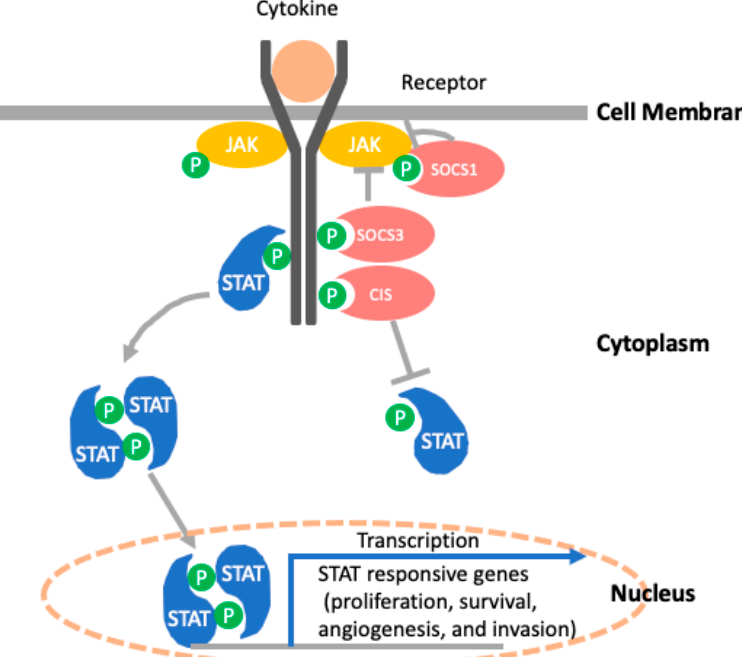
Figure 2. The representative mechanism of suppressor of cytokine signaling (SOCS) proteins. Cytokine binds to specific cytokine receptors and causes receptor dimerization or oligomerization and recruits Janus kinase (JAK)s. Activated JAKs phosphorylate the receptor cytoplasmic domain and assemble signal transducers and activators of transcription (STAT) dimers. The SOCS proteins inhibit cytokine signaling by binding to SOCS or phosphorylated JAKs. Cytokine-inducible Src homology 2 domain-containing protein (CIS) inhibits the recruitment of STAT. Abbreviation: JAK, Janus kinase; SOCS, suppressor of cytokine signaling; STAT, signal transducers and activators of transcription; CIS, cytokine-inducible Src homology 2 domain-containing protein.